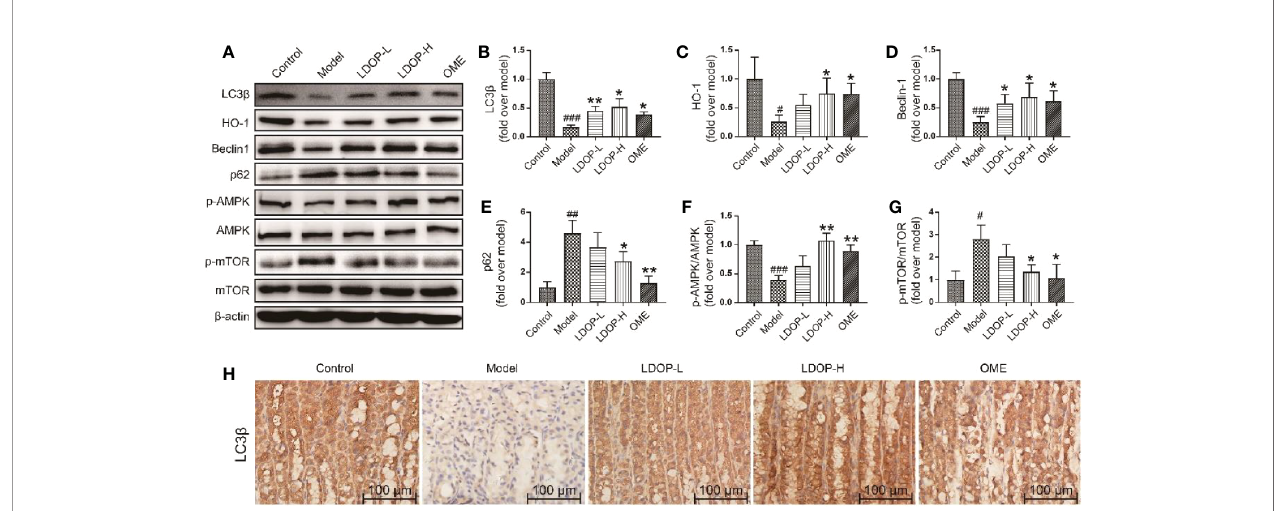
FIGURE 5 | The representative western blot images of LC3 b , HO-1, Beclin-1, p-AMPK, p62, p-mTOR and immunohistochemical image of LC3 b showed that LDOP-1 induced autophagy via AMPK/mTOR signaling way in vivo. (A) The expression of LC3 b , HO-1, Beclin-1, p-AMPK, p62, p-mTOR detected by Western blot. (B-G) Statistical analysis on LC3 b , HO-1, Beclin-1, p-AMPK, p62, p-mTOR. Immunohistochemical image of LC3 b (H) measured by immunohistochemical analysis (400×, brown yellow granules indicate positive reaction). Data are expressed as the mean ± SD of three independent experiments. # P<0.05, ## P<0.01, ### P < 0.001 compare the control group; *P<0.05 and **P<0.01 compare model group. LDOP-L stood for LDOP-1-L, LDOP-H stood for LDOP-1-H.